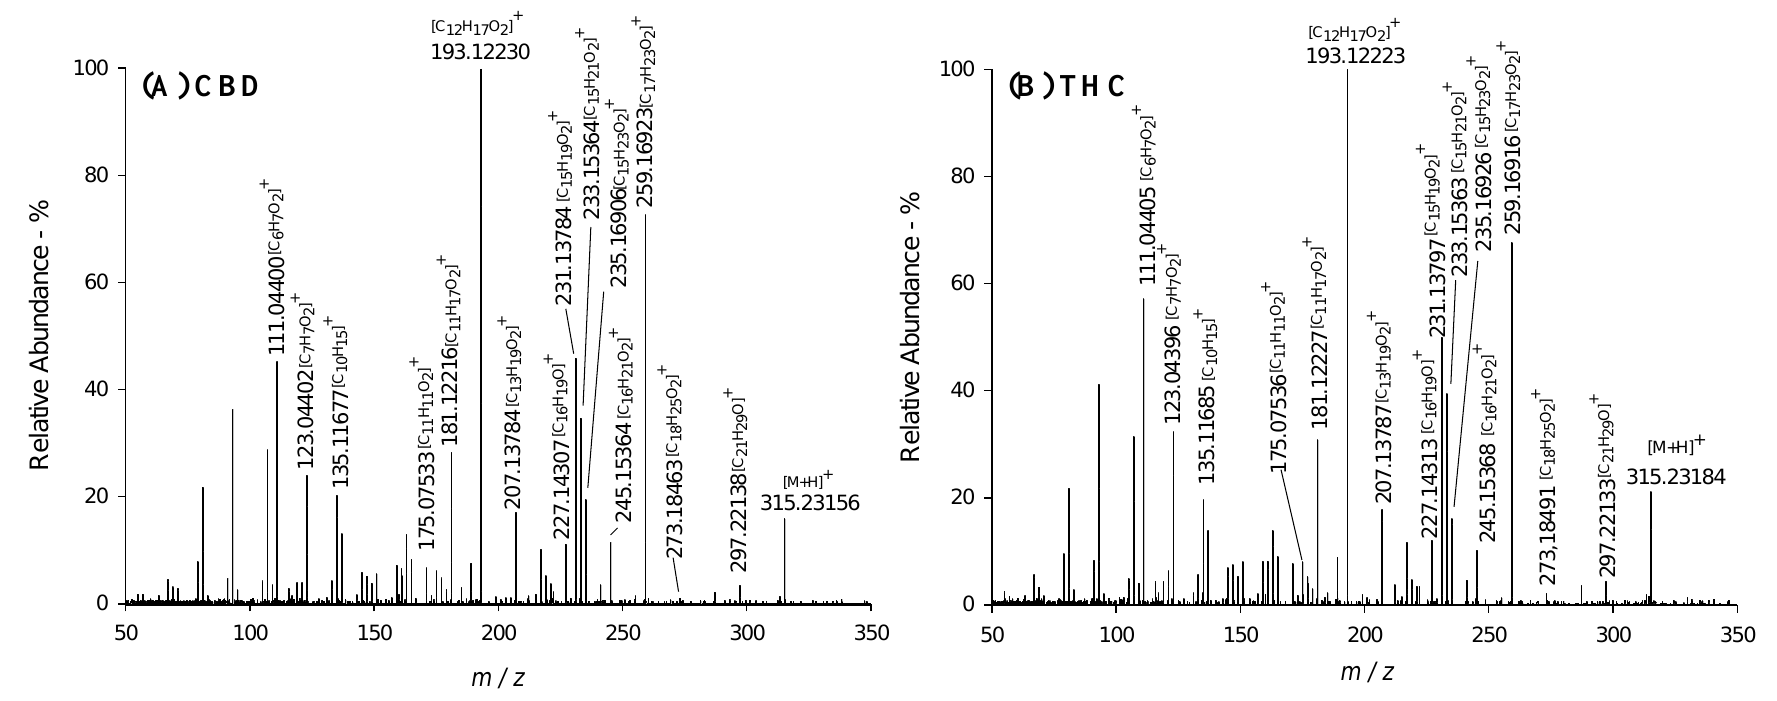
Figure 2. ( A ) FTICR IRMPD MS spectrum of the protonated cannabinoid CBD at m / z 315 (peak four in the chromatograms of Figure 1); the [M+H] + precursor ion was photon-irradiated for 300 ms at 100% laser power and ( B ) FTICR IRMPD MS spectrum of the protonated cannabinoid THC at m / z 315 (peak four in the chromatograms of Figure 1); the [M+H] + precursor ion was photon-irradiated for 300 ms at 100% laser power.